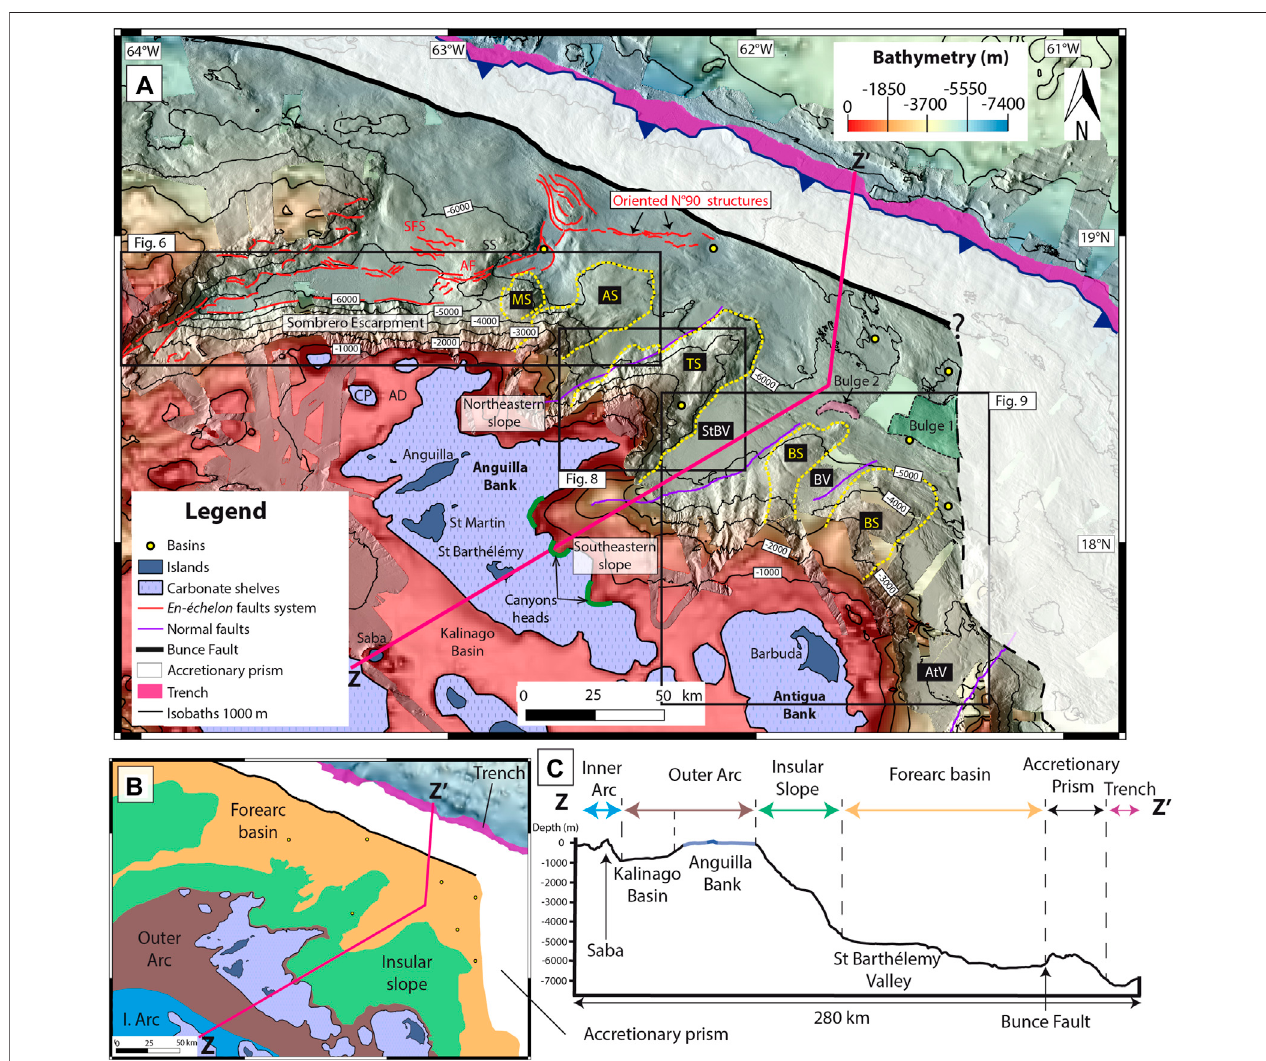
FIGURE5|(A) Morpho-bathymetricmapoftheNLAS.Thecross-sectionABisrepresentedinpinkinthemainmapandinthereducedmap,itrefersto Figure5B ). RedfaultsdemarcatetheAnegadaPassageEasternSegment,yellowdotsindicatefourmainspurs.AB:AnguillaBasin,AD:AnguillaDepression,AF:AnguillaFaults,AS: Anguilla Spur, AV: Antigua Valley, BS: Barbuda Spur, BV: Barbuda Valley, CP: Crocus Platform, MS: Malliwana Spur, SFS: Sombrero Faults System, SS: Sombrero Saddle, StBV: St Barthélémy Valley, TS: Tintamarre Spur. (B) Reduced map of the main domains. (C) ZZ ′ cross-section. The colors of the main domains double arrows are the same as in the insert map in Figure 5B